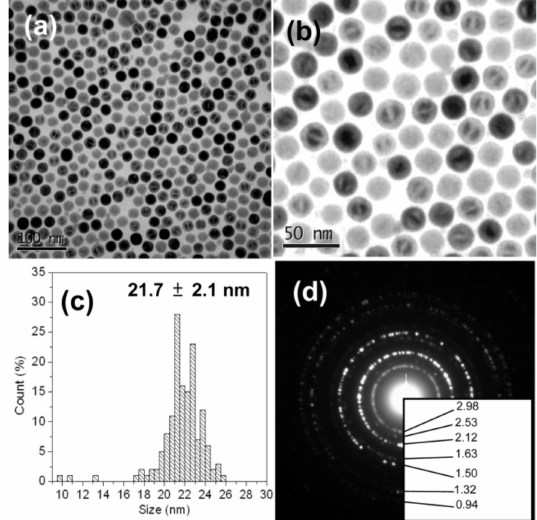
Figure 3. ( a , b ) TEM of FeO nanoparticles synthesized by thermal decomposition, ( c ) particle size distribution plot, ( d ) SAED pattern. Obtained permission from Ref. [53]. Copyright 2010 American Chemical